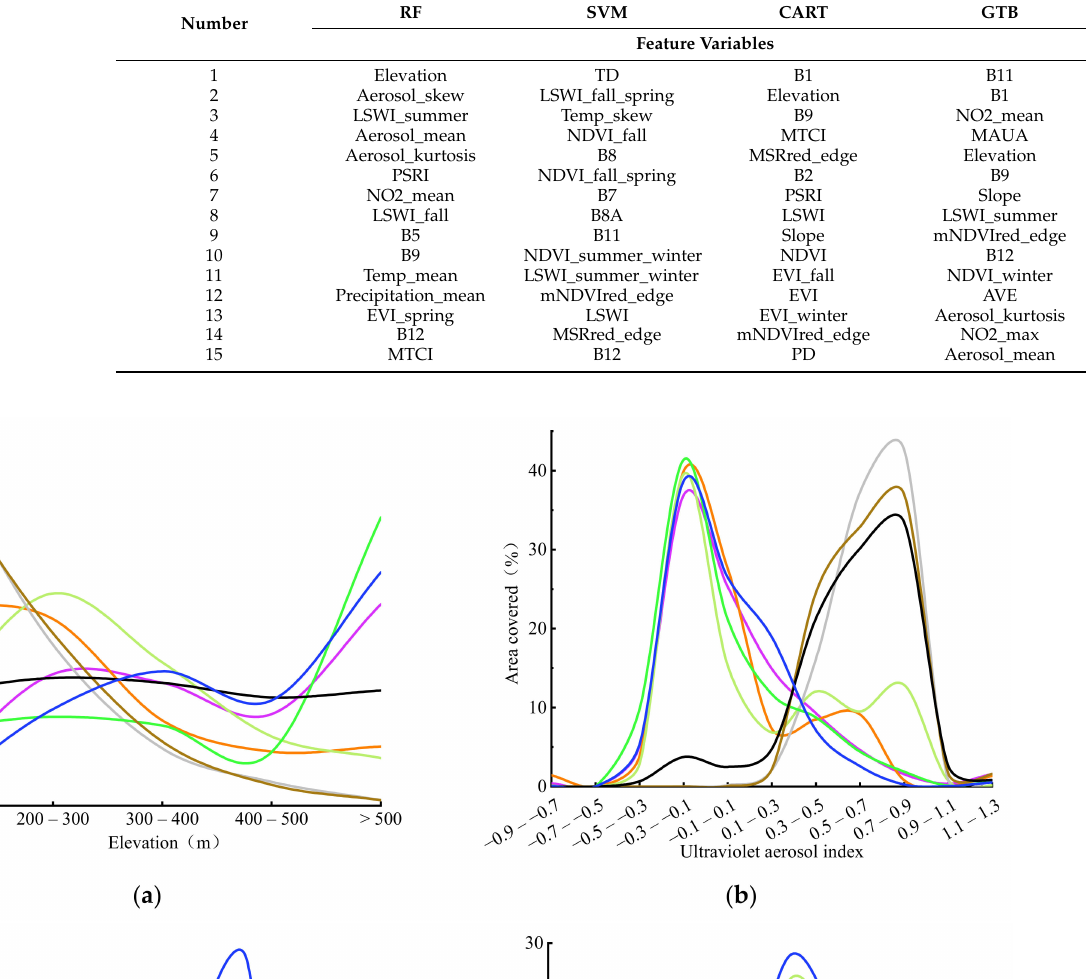
Table 7. Fifteen feature variables along with the importance score ranks for the four algorithms.